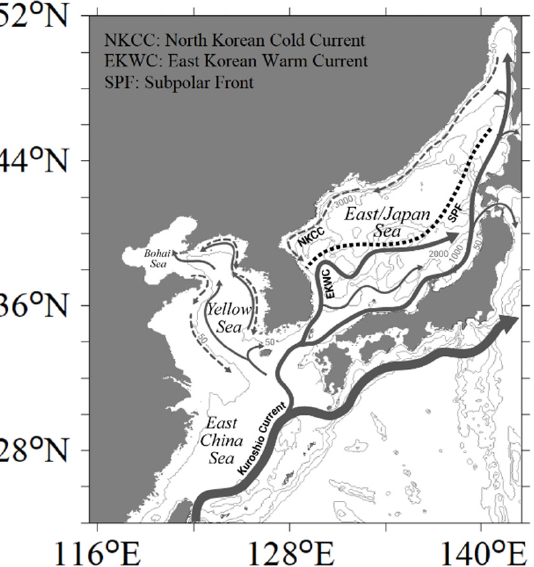
Figure 1. Schematic map of the surface currents overlaid on the bottom topography in East Asian Marginal Seas separated into two regions: the East/Japan Sea (EJS) and the Yellow & East China Seas, including the Bohai Sea (YECS). Solid (dashed) arrows indicate the warm (cold) ocean current. The dotted line indicates the subpolar front (SPF).